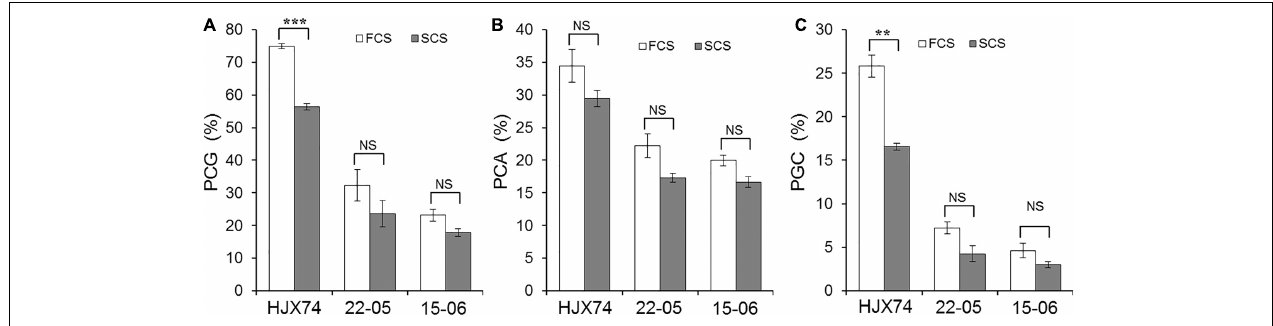
FIGURE 4 | The chalkiness phenotypes of HJX74, 22–05 and 15–06 in the first cropping season (FCS) and the second cropping season (SCS). (A) PCG, Percentage of chalky grain. (B) PCA, Percentage of chalky area. (C) PGC, Percentage of grain chalkiness. ** and ***, Significant difference at the 0.01 and 0.001 levels, respectively. NS, No